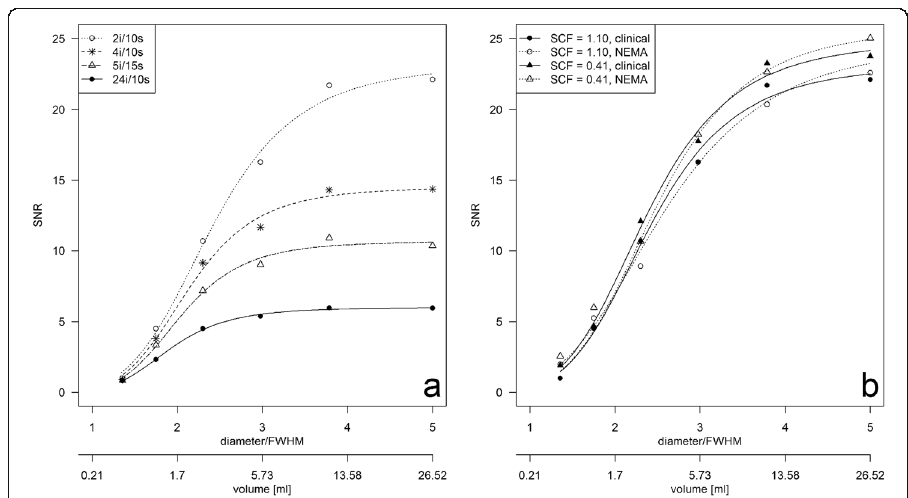
Fig. 2 Effect of the reconstruction setup on the signal-to-noise ratio (SNR) of the examined spheres. a SNR of the clinical acquisition protocol (60 projections, 20 s/projection) for different reconstruction setups (SCF 1.10 in combination with four different iteration sets). b SNR for a fixed set of iterations (2i/10s) demonstrating effects by the acquisition protocol (clinical or NEMA) and SCF (1.10 or 0.41). HSRC was plotted against sphere diameter normalized to FWHM at 100 mm with LEHR collimator (FWHM = 7.4 mm) and sphere